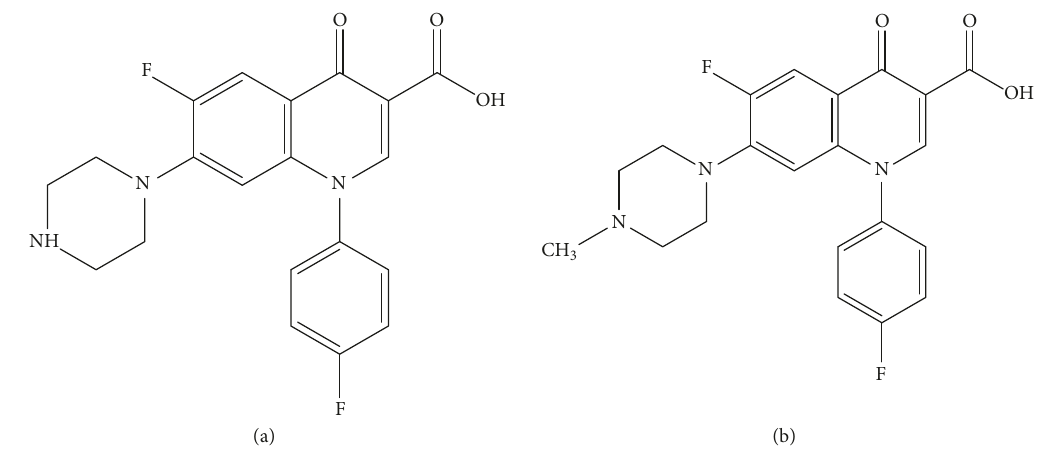
Figure 1: The chemical structure of (a) sarafloxacin and (b)